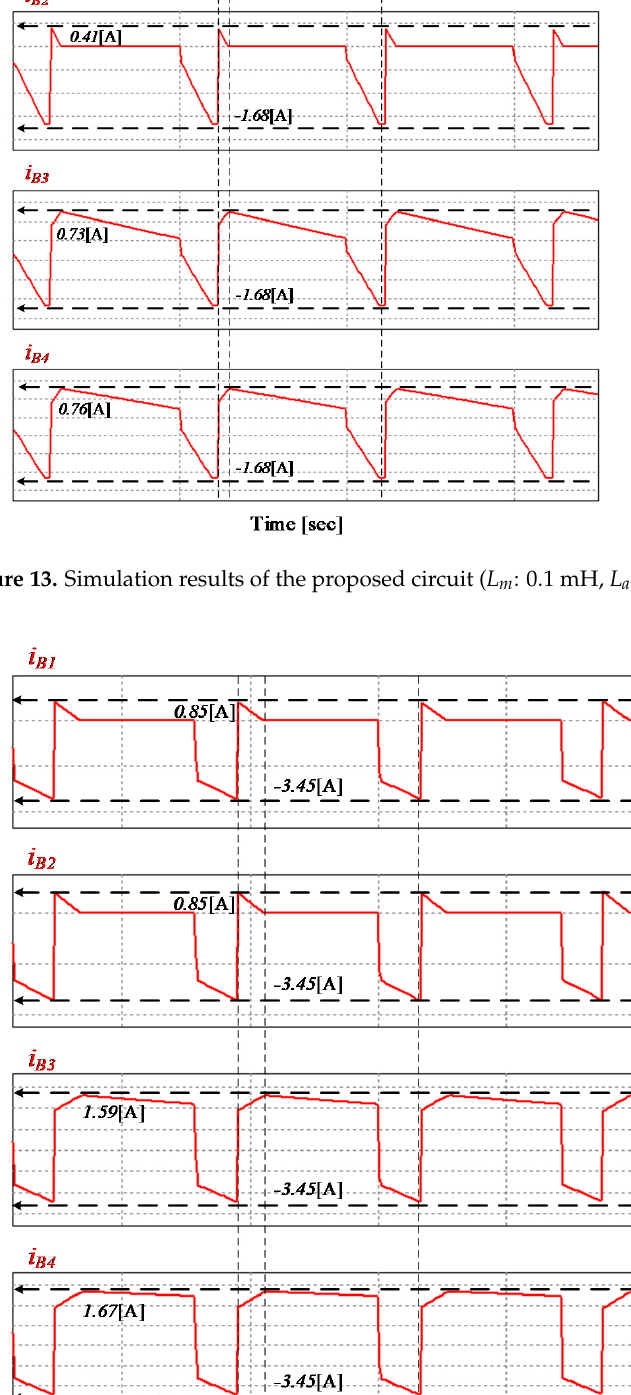
Figure 14. Simulation results without the auxiliary circuit ( L m : 1.1 mH).